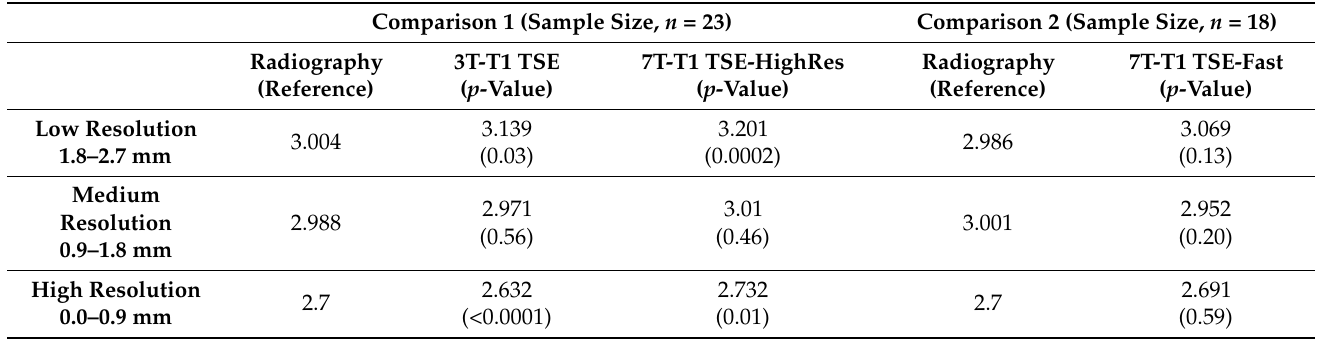
Table 4. Comparison of horizontal fractal dimensions between radiography and different MRI T1 sequences in the “patient” group.